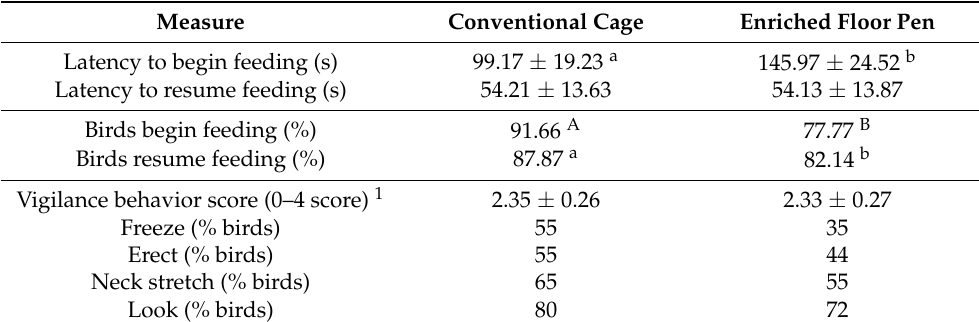
Figure 1. Least square mean estimates ( ± SEM) of tonic immobility (TI) duration at week 23 of age ( n = 24 birds/treatment) for hens that were housed in conventional cages and hens that were housed in enriched floor pens. Bars lacking a common superscript tend to differ at p < 0.1. Table 2. Responses in the attention bias test at 30 weeks of age for laying hens that were housed in conventional cages ( n = 36) or enriched floor pens ( n = 36).